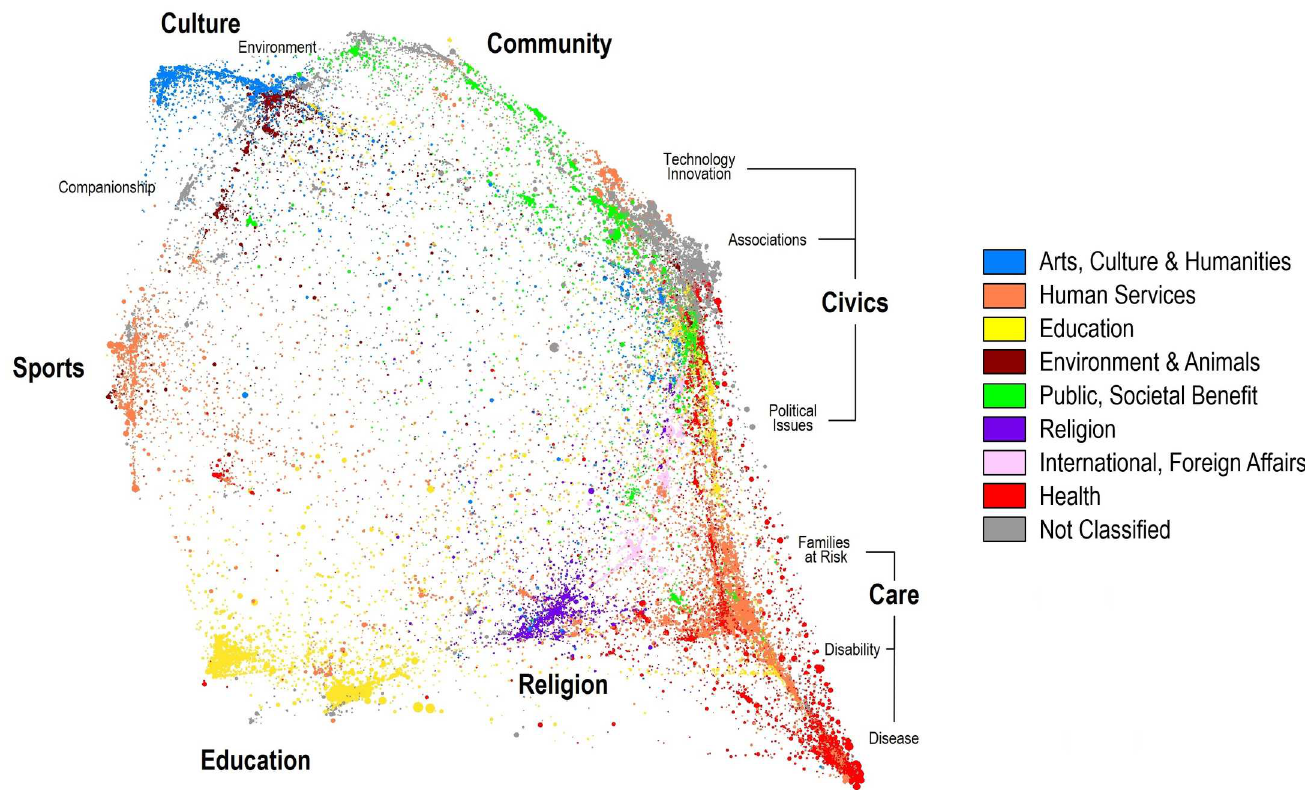
Fig 2. A map of altruistic missions for 125,000NPOs in the United States. Each NPO is represented by a dot, and is color codedusing high-level NationalTaxonomy of Exempt Entities (NTEE) categories (see legend).